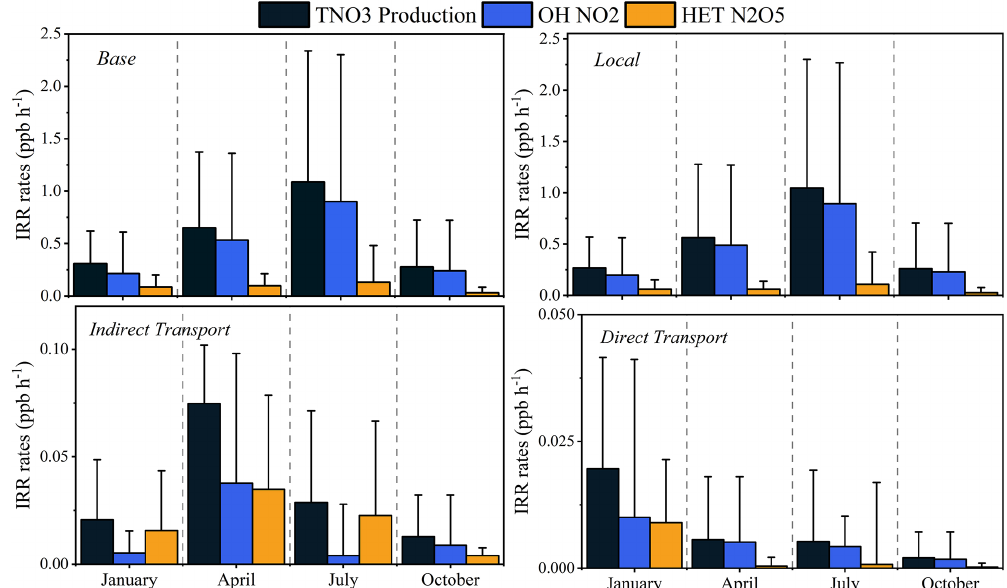
Figure 8. The seasonal rates of TNO 3 − production and the major pathways in the base case and from the local and transport contributions within the PBL. The error bar indicates 1 standard